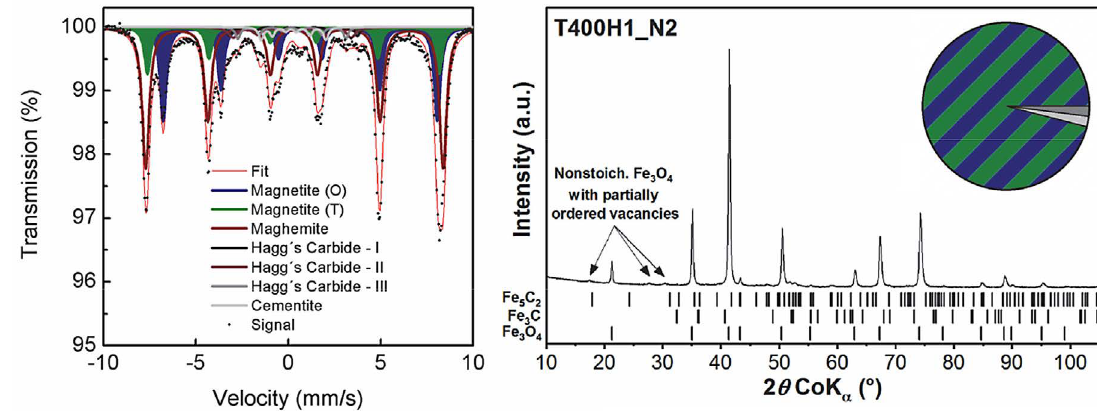
Figure 2. Mössbauer and XRD data of sample